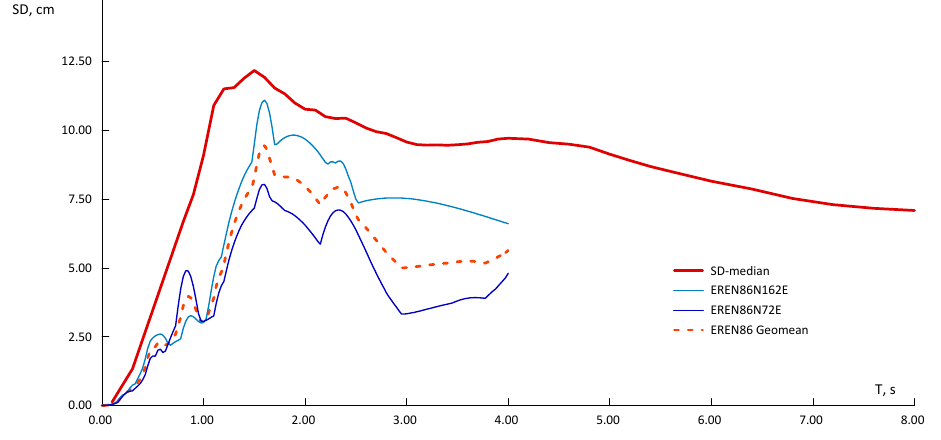
= 121 km), 1986 earthquake ( M